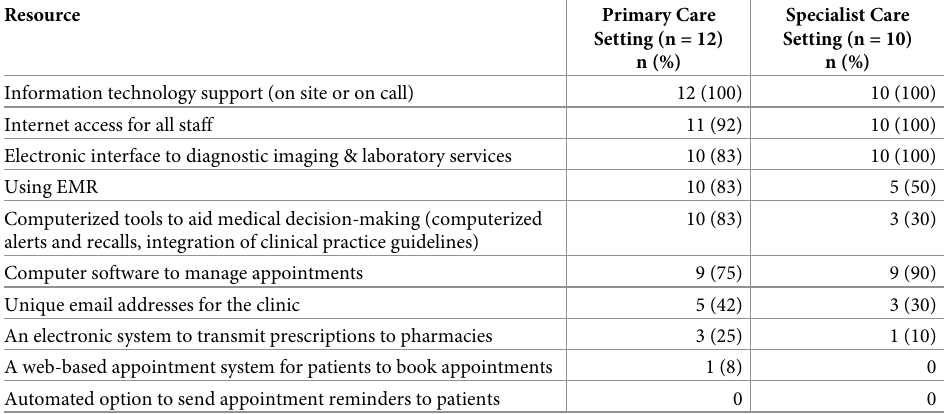
Specialist Care Setting (n = 12) Setting (n = 10) n (%) n (%) 10 (83) 3 (30) 5 (42) 3 (30)